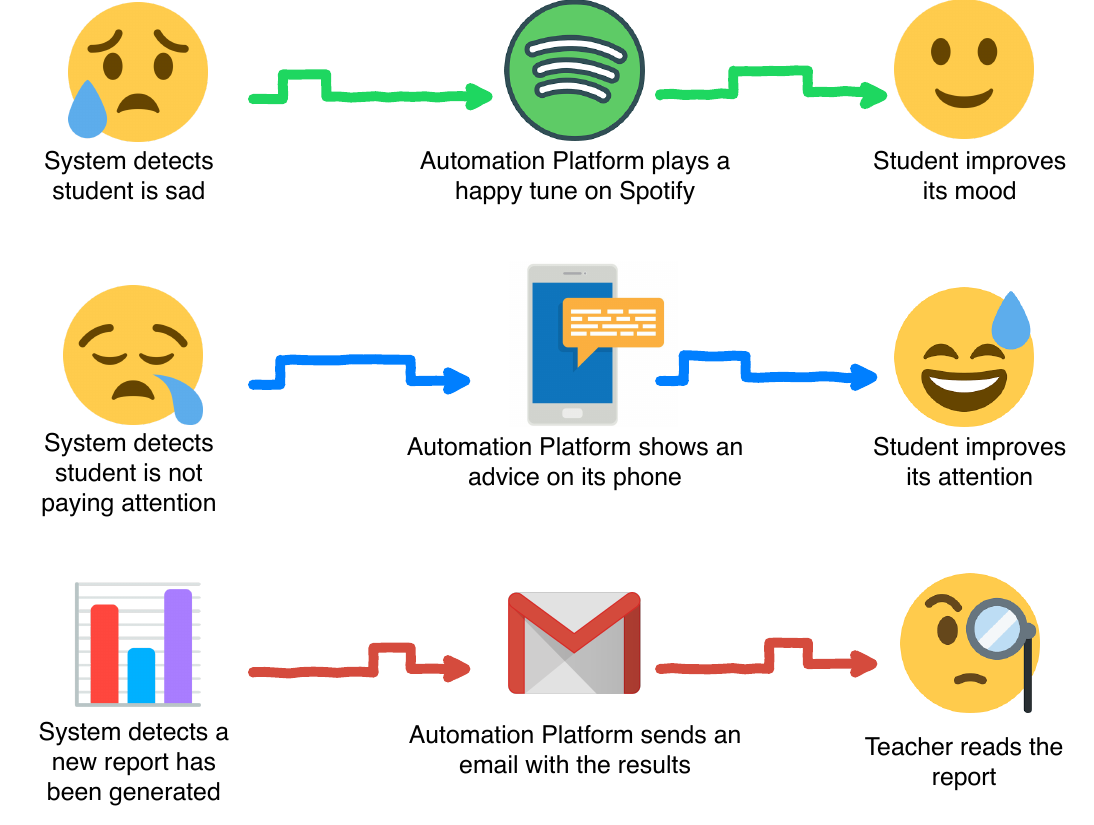
Figure 8. Smart automation